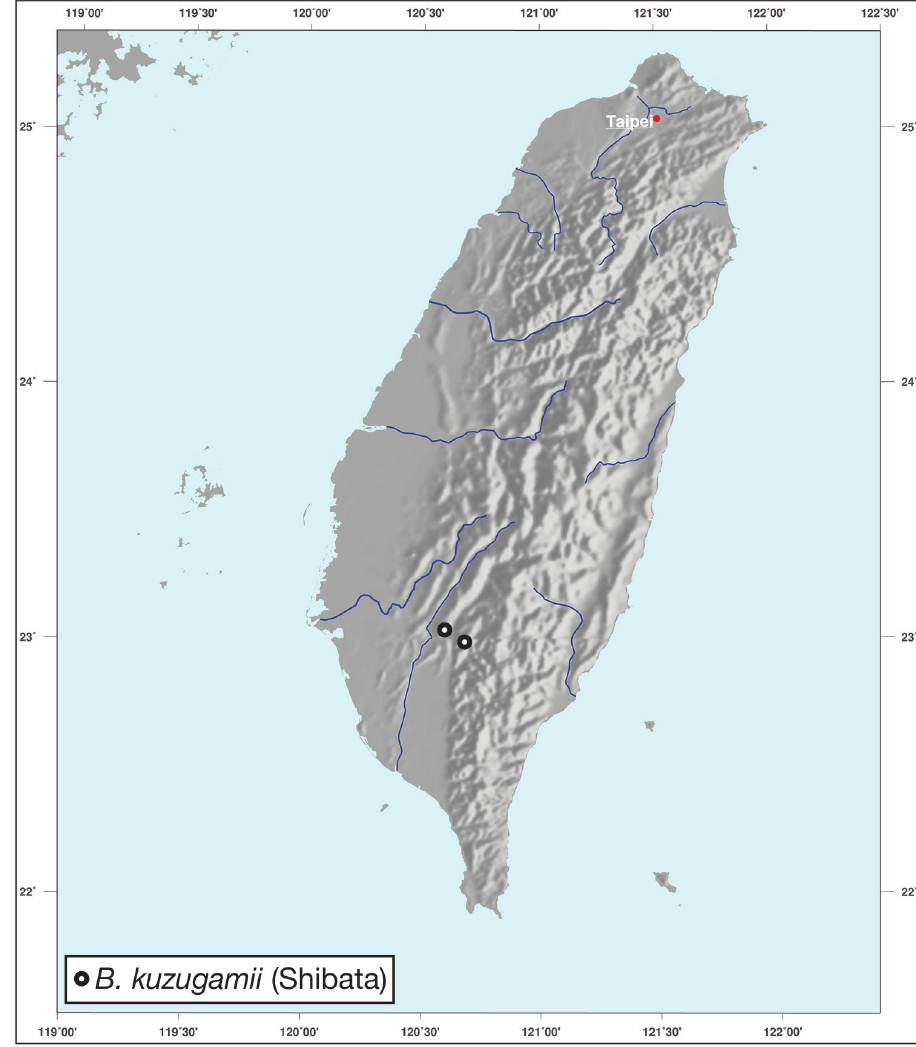
Figure 16. Map showing known localities for species of the genus Bellavalentis gen. n., in